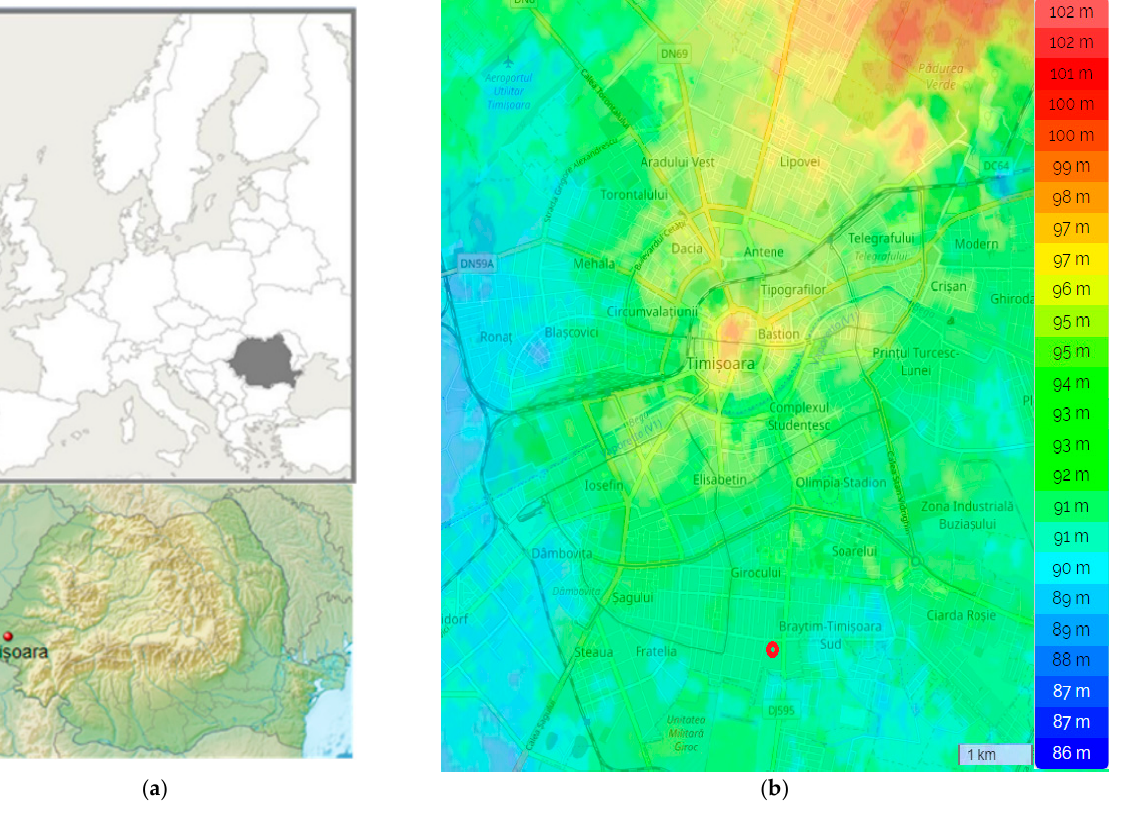
oara’s urban layout on topographic map and location of ,